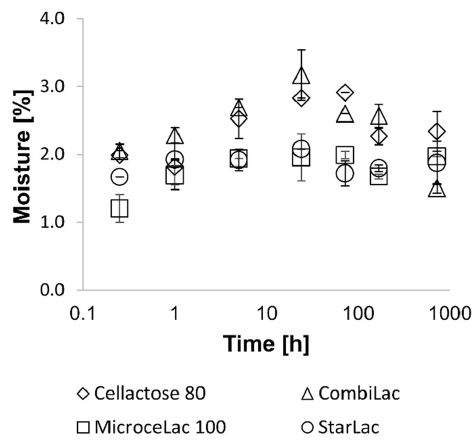
Figure 4. Hygroscopicity of CPEs.